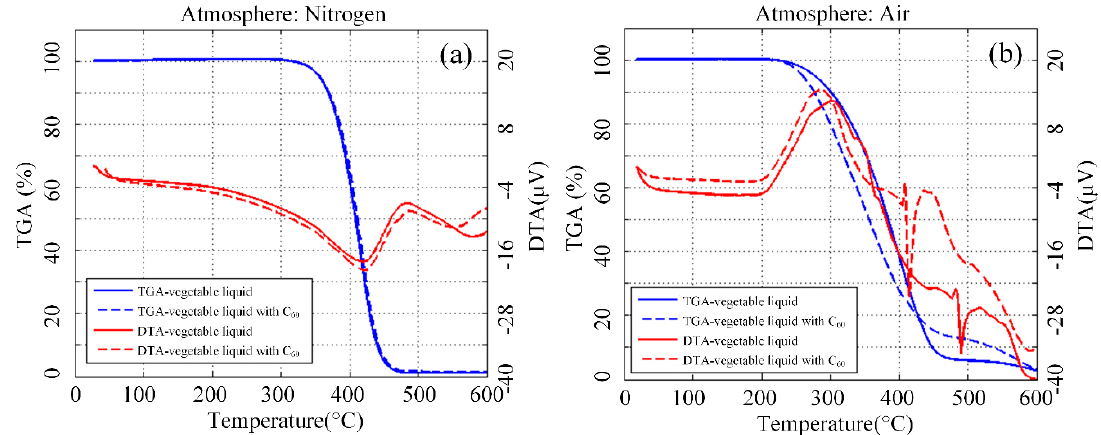
Figure 9. TGA and DTA curve of C 60 modified vegetable insulating liquid and its pure sample in nitrogen ( a ) and air ( b ) atmosphere. nitrogen ( a ) and air ( b )